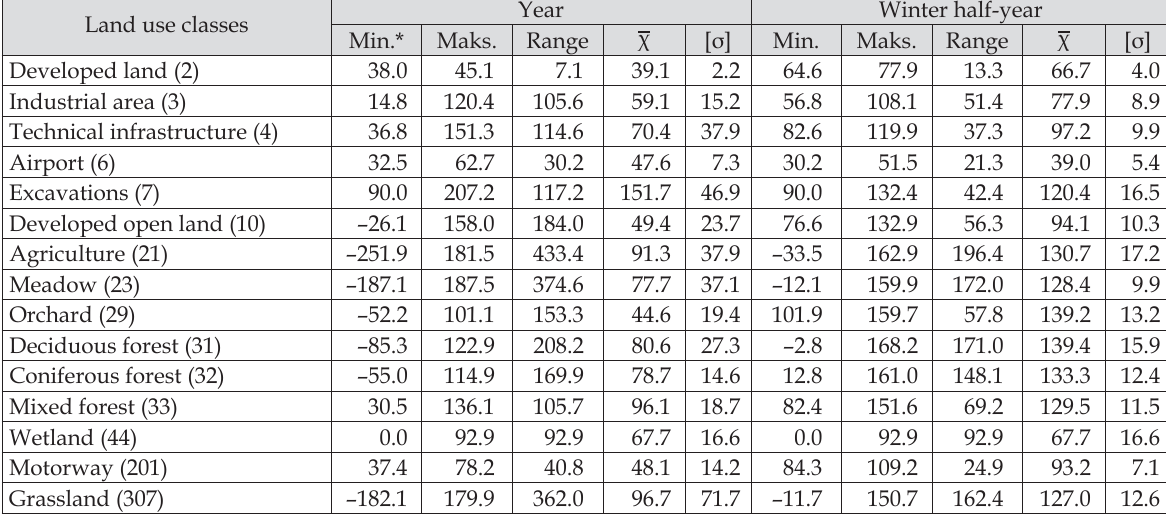
Table 2. Variability range of the effective infiltration volume [mm] in land use classes – WetSpass model results for the year and winter half-year